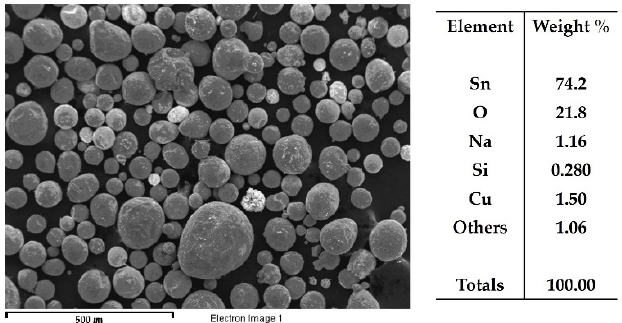
Figure 8. The condensed phase of volatilized tin by SEM/EDX analysis.